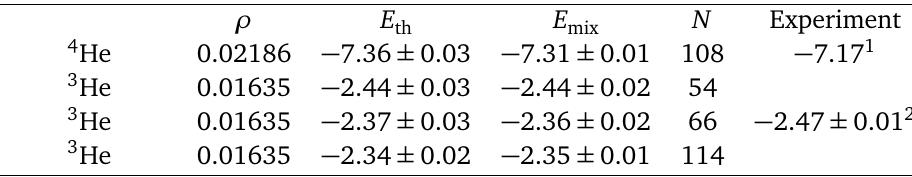
Figure 8: Ground state total energy per particle in units of K as a function of the projection time. The upper panel show results for 108 4 He atoms and the lower one for 54 3 He atoms. Circles display estimates with the thermodynamic estimator, and squares indicate estimates with the mixed estimator. Statistical uncertainties, when not visible, are smaller than the symbol size. Table 1: Ground state total energy per particle of each pure system (first column) and densities in units of Å − 3 (second column). Results were obtained using the ther- modynamic E (third column) and the mixed E estimators (fourth column). In th mix the last columns, the number of particles N considered at each simulation is reported along with the experimental value. All the energies are in units of